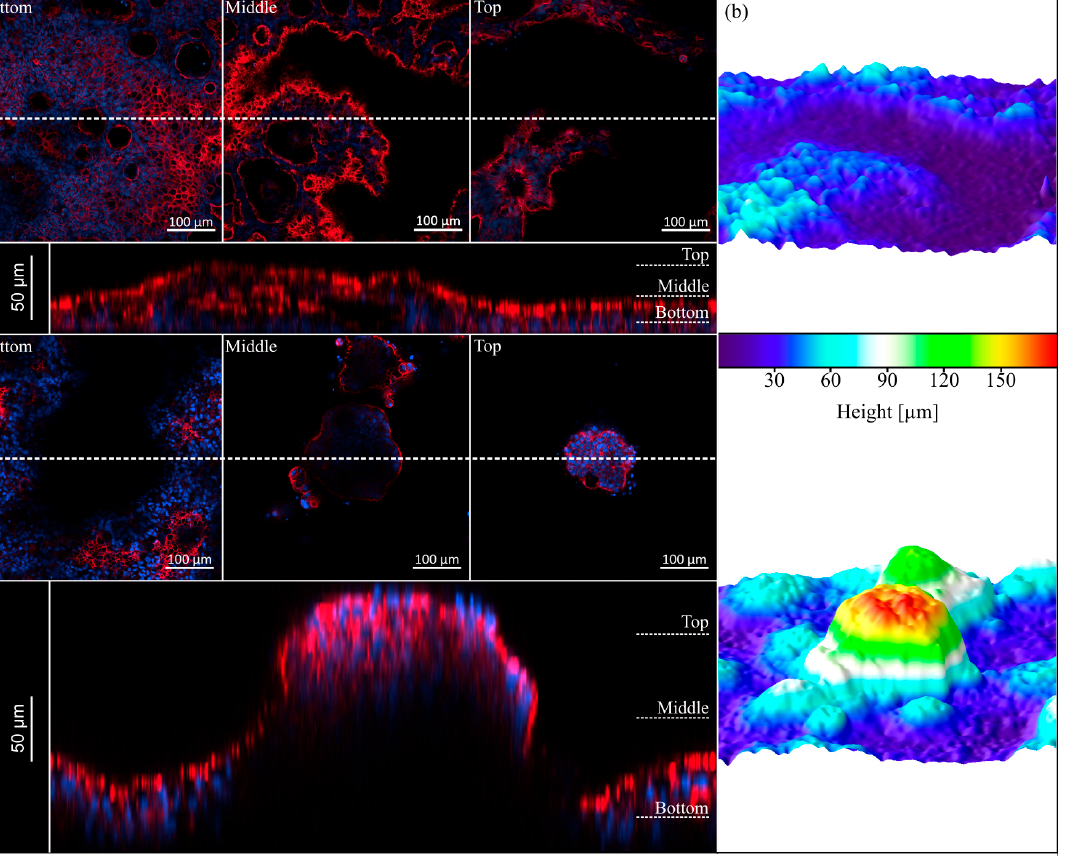
Figure 3. Topography of HT29-MTX cells under static and dynamic conditions after three weeks of culture. ( a ) Confocal images of F-actin (red) and nuclei (blue) staining at different z-positions (Bottom, Middle, Top) and representative orthogonal views below (the dotted line indicates the cutting plane). ( b ) Corresponding 3D surface reconstructions of z-stacks of the epithelium, modelled by ImageJ.